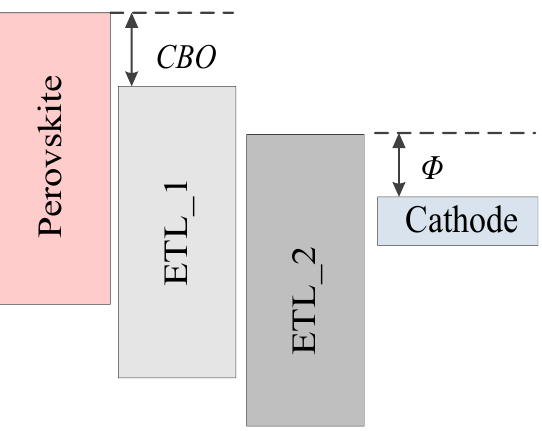
Figure 9. Schematic diagram of conduction band offset ( CBO ) and Φ in a double ETL structure.